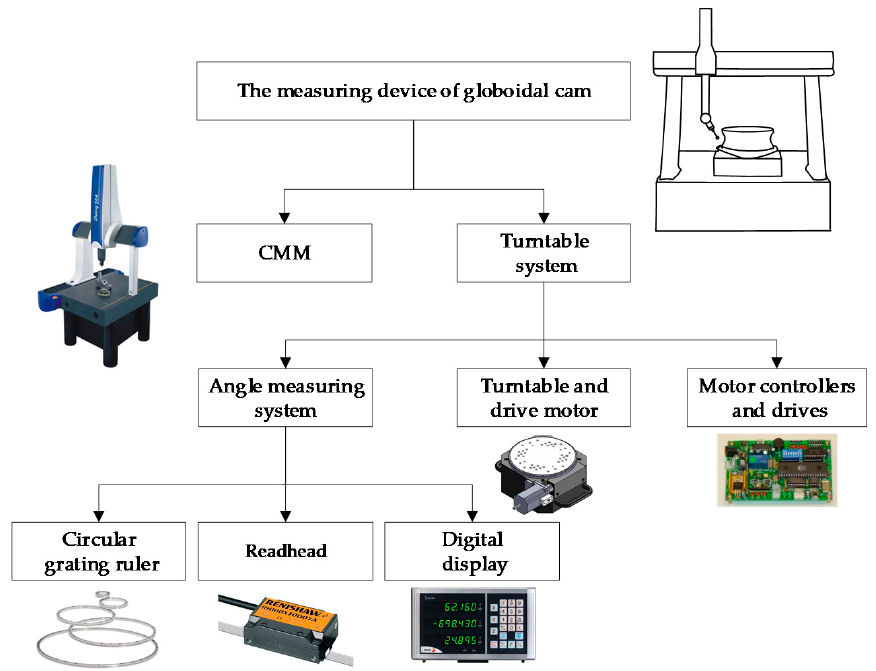
Figure 4. Structure of online measuring system for globoidal cam.